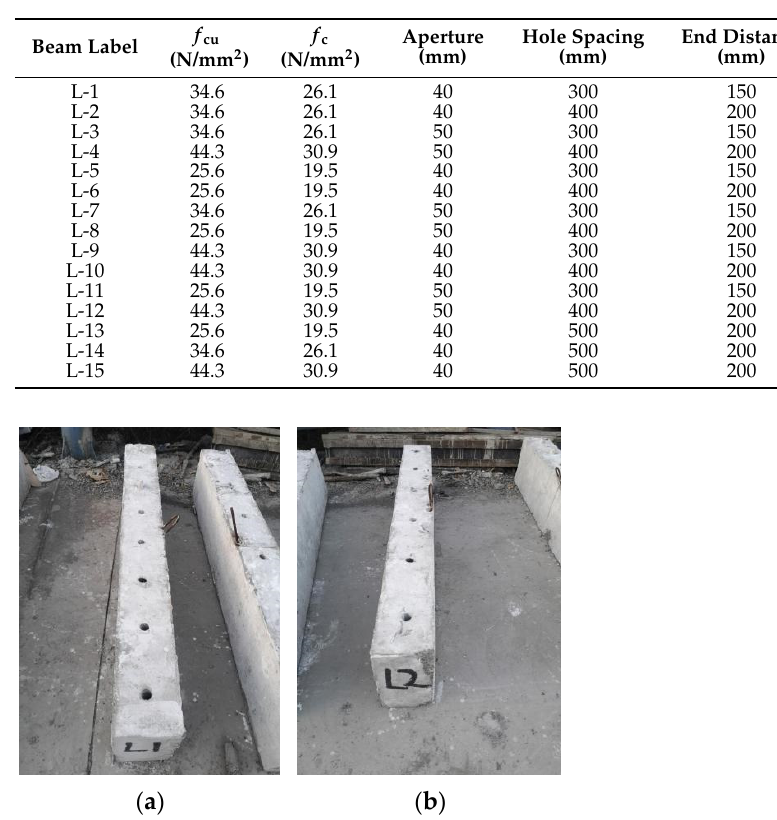
Figure 2. Reinforcements of beams. Table 2. Main design parameters of the specimens.